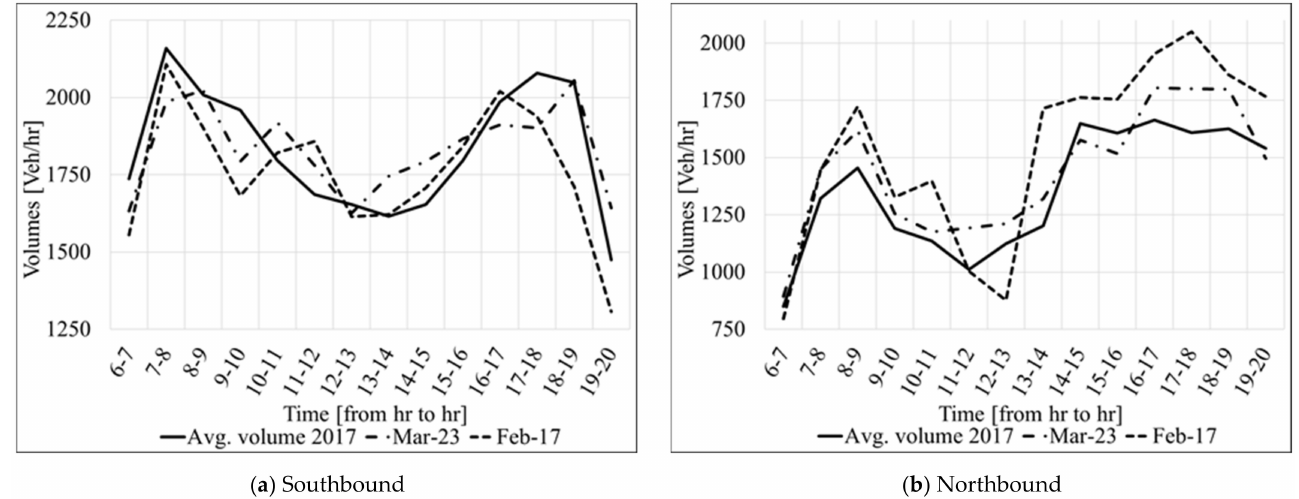
Figure 2. Average hourly traffic volume for 2017 and the representative